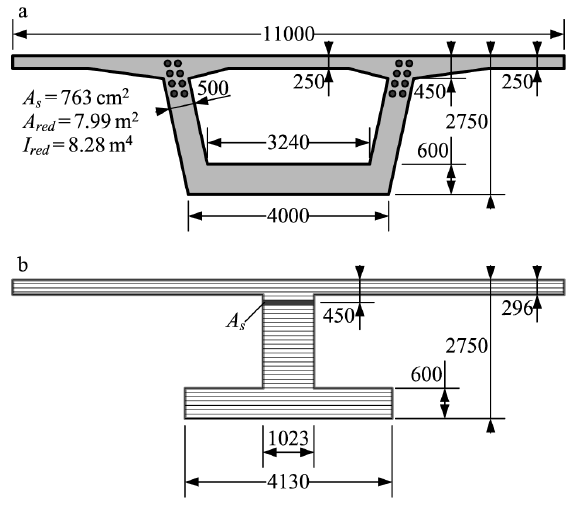
Fig. 7. Box girder cross-section (a) and its Layer model (b)